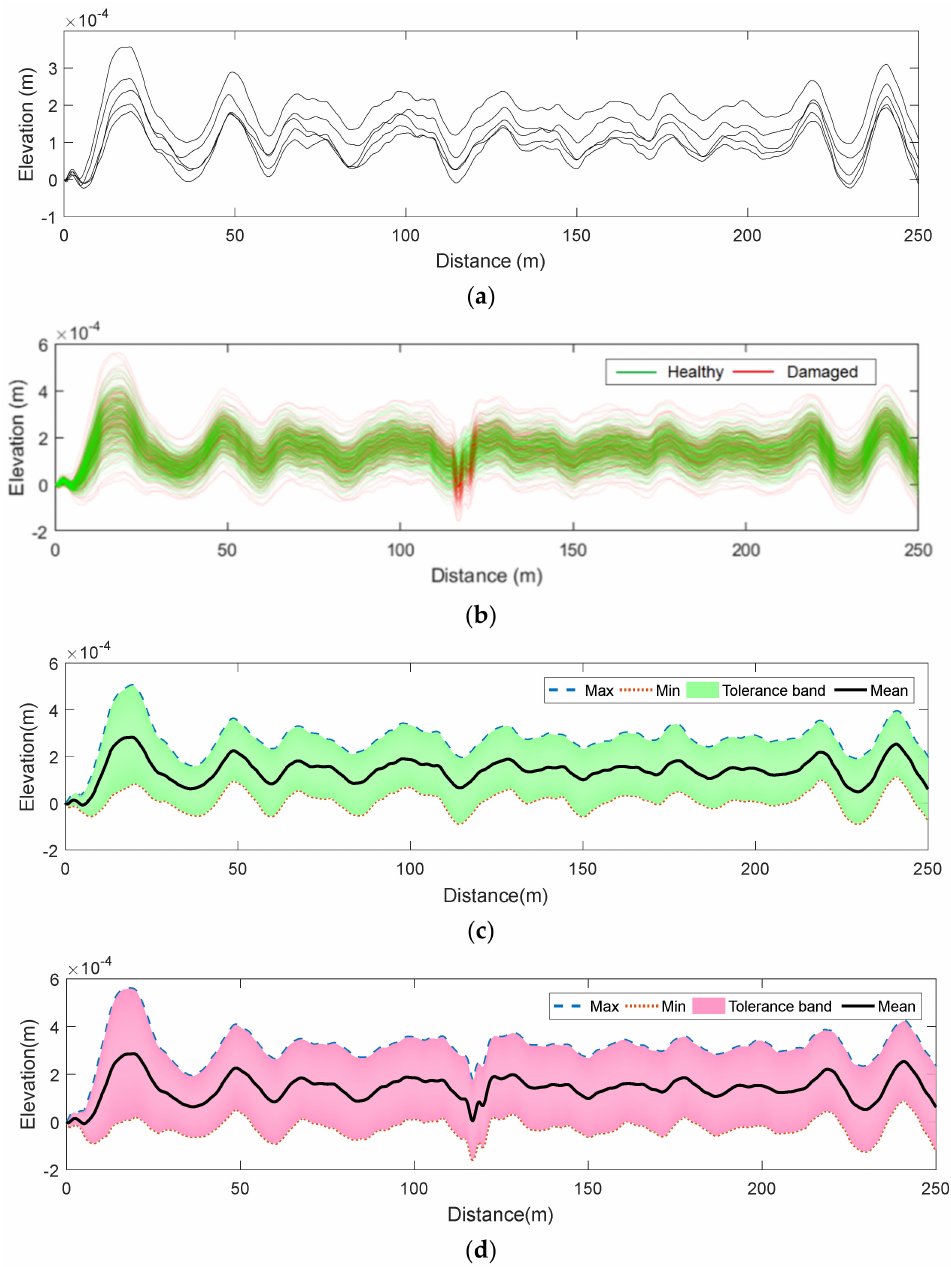
Figure 13. ( a ) The BFDs for the first five passes on the healthy track, ( b ) the BFDs for the populations of passes for the healthy and damaged cases, ( c ) the mean and tolerance band of the healthy population, and ( d ) the mean and tolerance band for the damaged